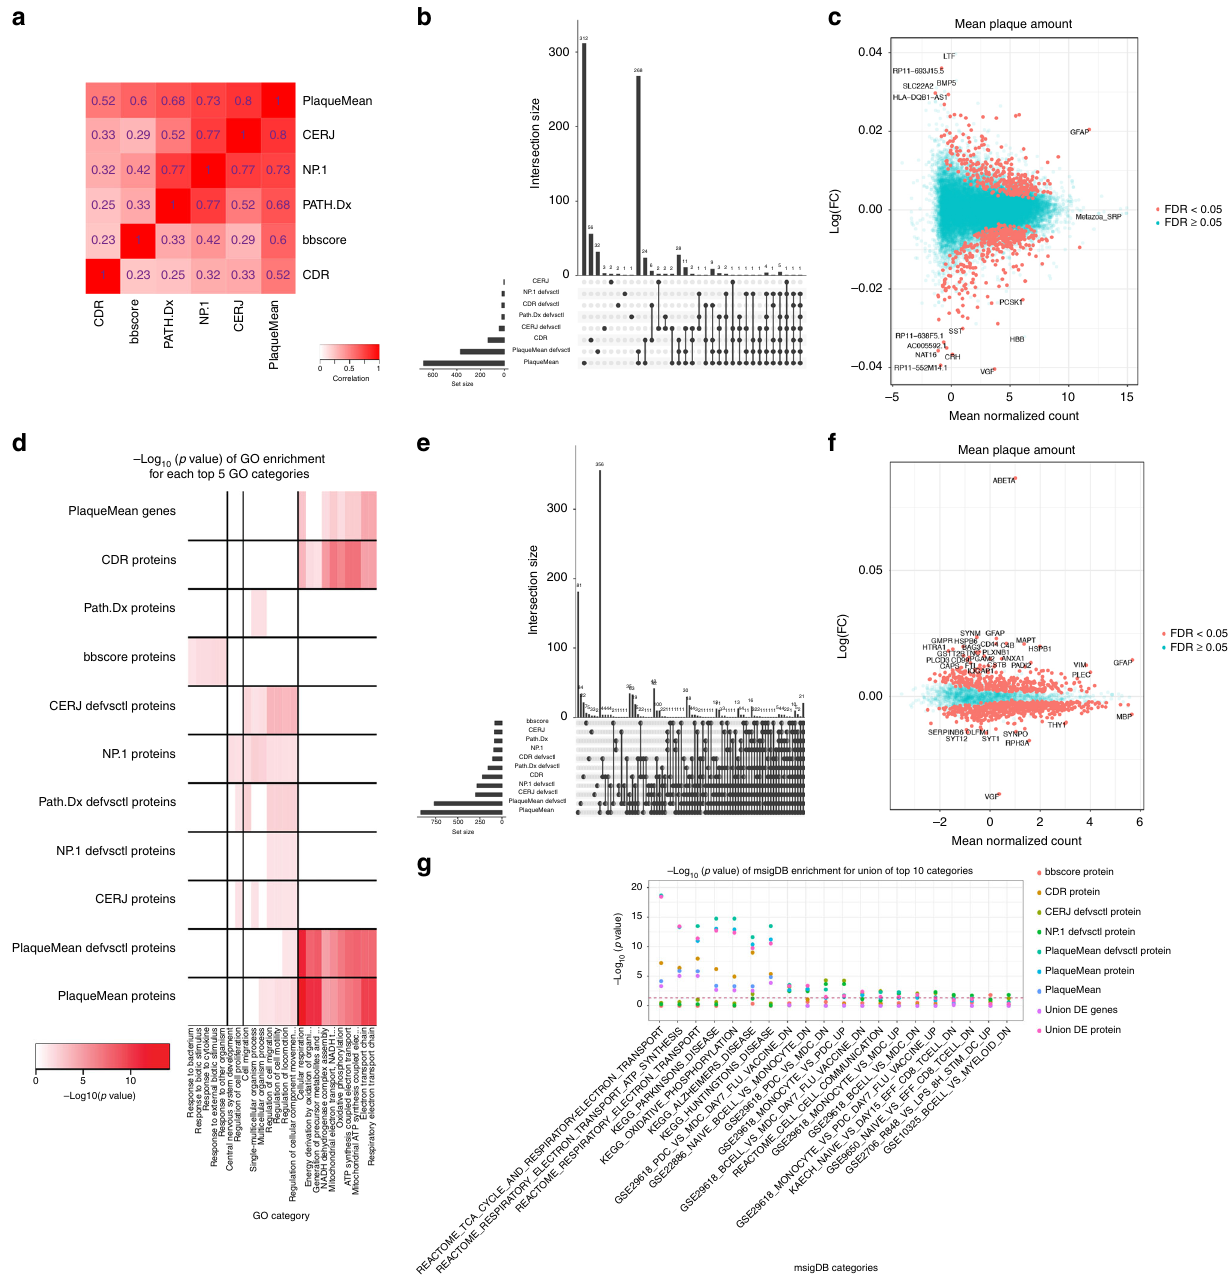
Fig. 2 Characterization of AD traits, and brain gene and protein expression. a Canonical correlation heatmap of disease traits. The intensity of the red color indicates the strength of correlation between traits; the canonical correlation is indicated in each box. The x - and y -axis represent the traits: clinical dementia rating (CDR), Braak score (bbscore), clinical neuropathology (PATH.Dx), neuropathology category (NP.1), CERAD neuropath criteria (CERJ), and mean neocortical plaque density (number of plaques/mm 2 , PlaqueMean). b , e Breakdown of DE genes ( b ) and proteins ( e ). This fi gure shows the UpsetR plot ( “ Methods ” ) of the DE genes or proteins overlapping across tests. The bars represent the size of the DE sets and the points represent the category to which each set belongs. c , f PlaqueMean DE genes ( c ) and proteins ( f ). The x -axis is the mean normalized count for each gene or protein and the y -axis is their log fold change. Blue and red genes and proteins correspond to FDR ≥ 0.05 and FDR < 0.05, respectively. The strongest DE genes are highlighted on the plot. d GO term enrichment across all signatures. The heatmap depicted represents the − log 10(FDR) of the top 5 most signi fi cant GO terms associated with signatures across all traits. Rows are GO terms and columns signatures. g MsigDB pathway enrichment for all signatures. The barplot represents the union of the top 10 signi fi cant MsigDB categories associated to signatures for all traits; x - and y -axis are MsigDB terms and the − log 10 (FDR), respectively. Colors represent the individual